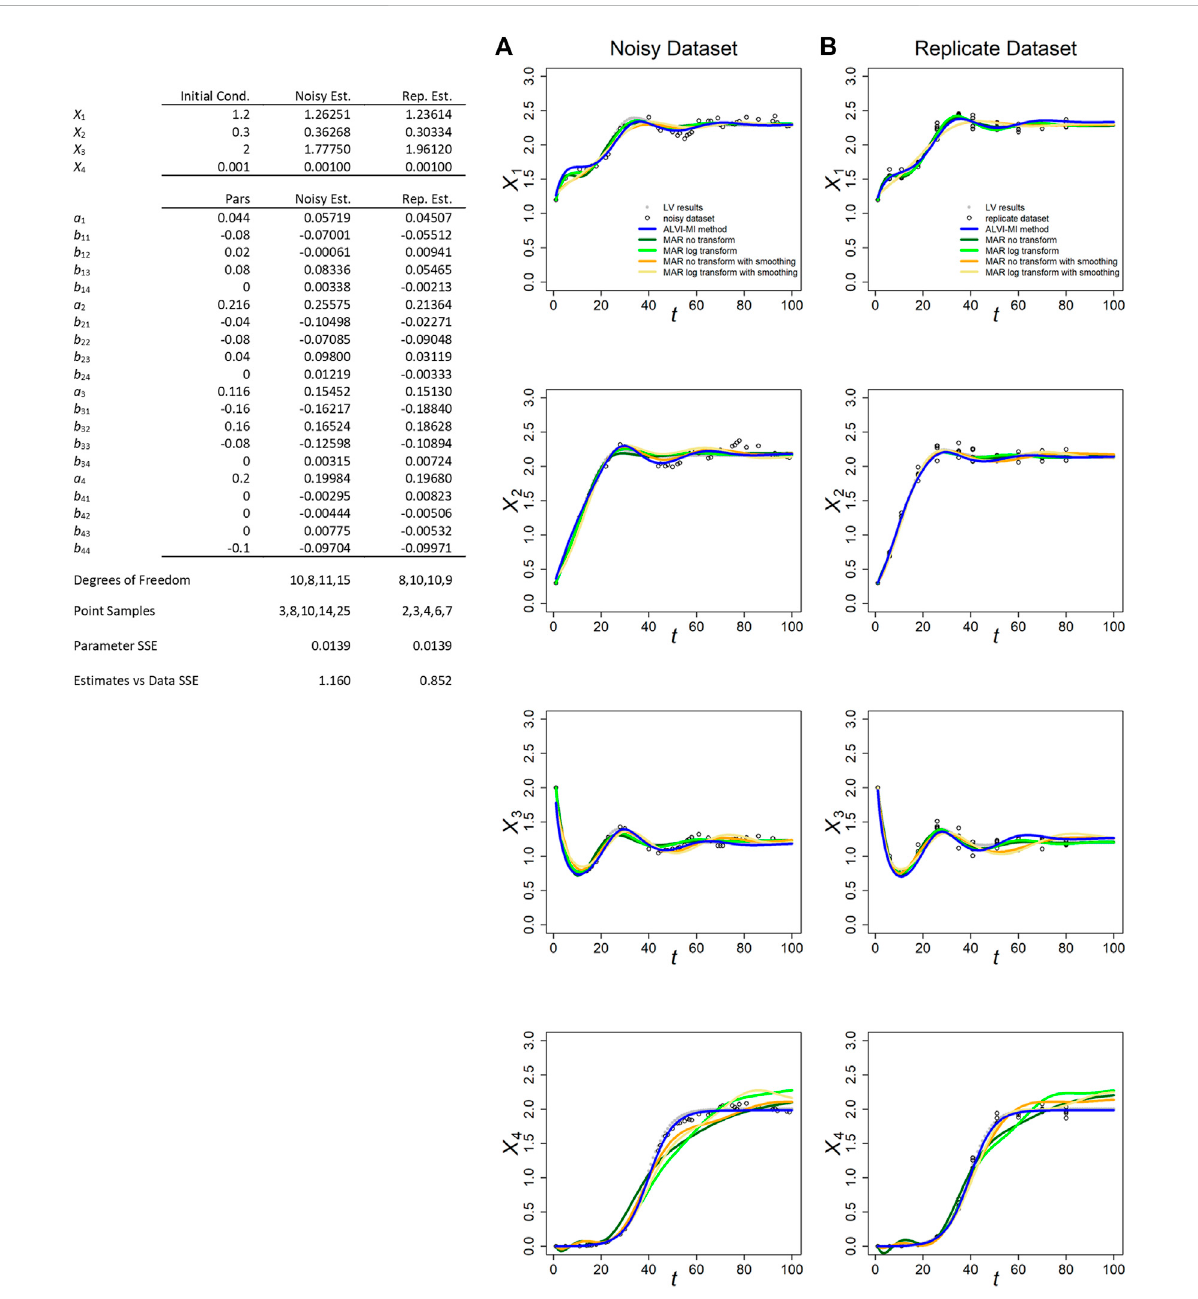
FIGURE 1 ALVI-MIandMARSSmethodsappliedtonoisy (A) andreplicate (B) LVdatasetswithprocessnoise.Originalsyntheticdataareshownasgraydots and data with added noise as black circles. LV results are presented in blue. True parameters and LV estimates are presented in the Table. MAR estimates are presented in green, orange and yellow. Data and parameter estimates for MAR can be seen in Supplementary Table S1. SSEs for all fi ts are presented in Table